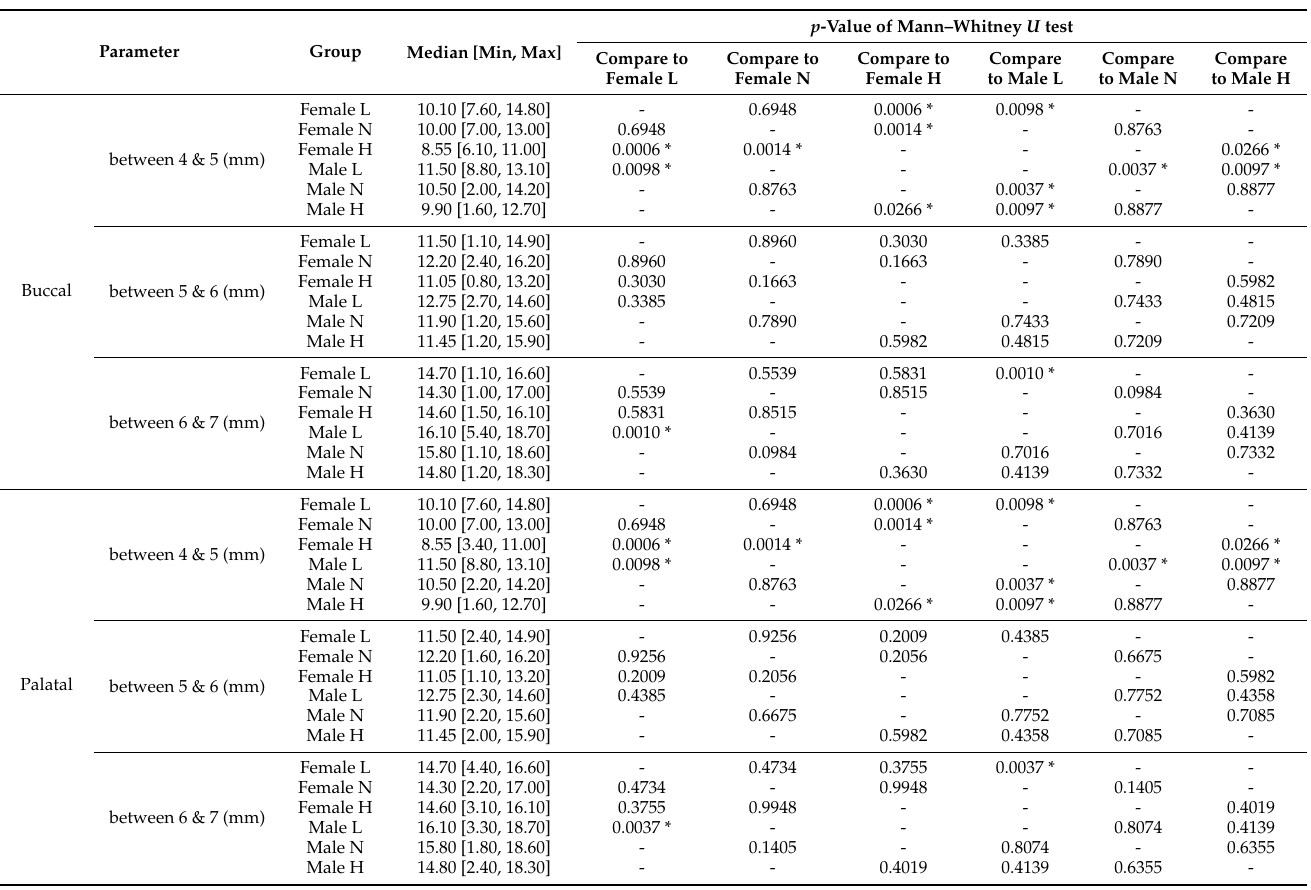
Table 6. The comparison of buccal and palatal alveolar bone thickness among groups at the level 8 mm above the alveolar crest. L: low-angle; N: normo-angle; H: high-angle. 4: first premolar, 5: second premolar, 6: first molar, 7: second molar. *: p < 0.05.